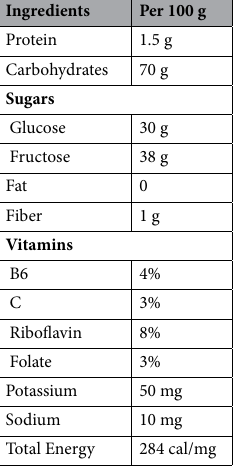
Table 2. Honey composition. Honey analysis was made by ASA Laboratory (Tehran, Iran) based on ISIRI- 7610, ISIRI-92 and European Honey Directive and the Codex Alimentarius Standard for Honey